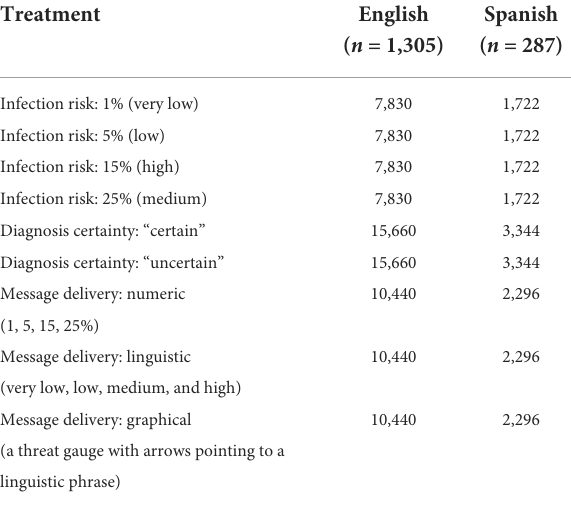
TABLE 1 Experiment treatments and the number of round per treatment by participant group.